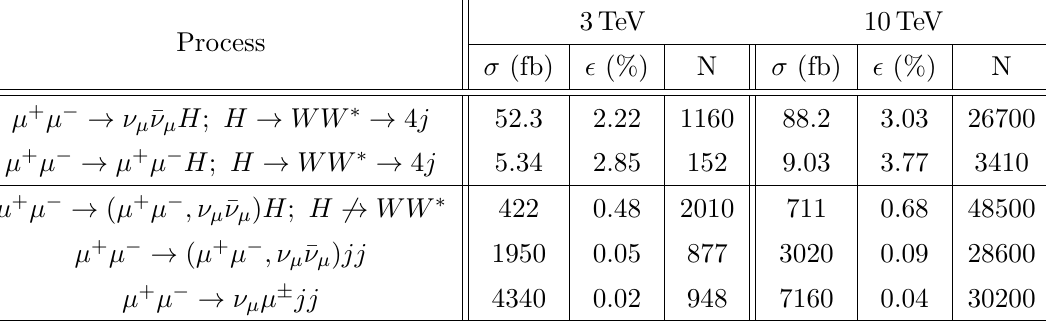
¯ ν ) H ; H 6→ WW ∗ includes all other hadronic modes µ µ